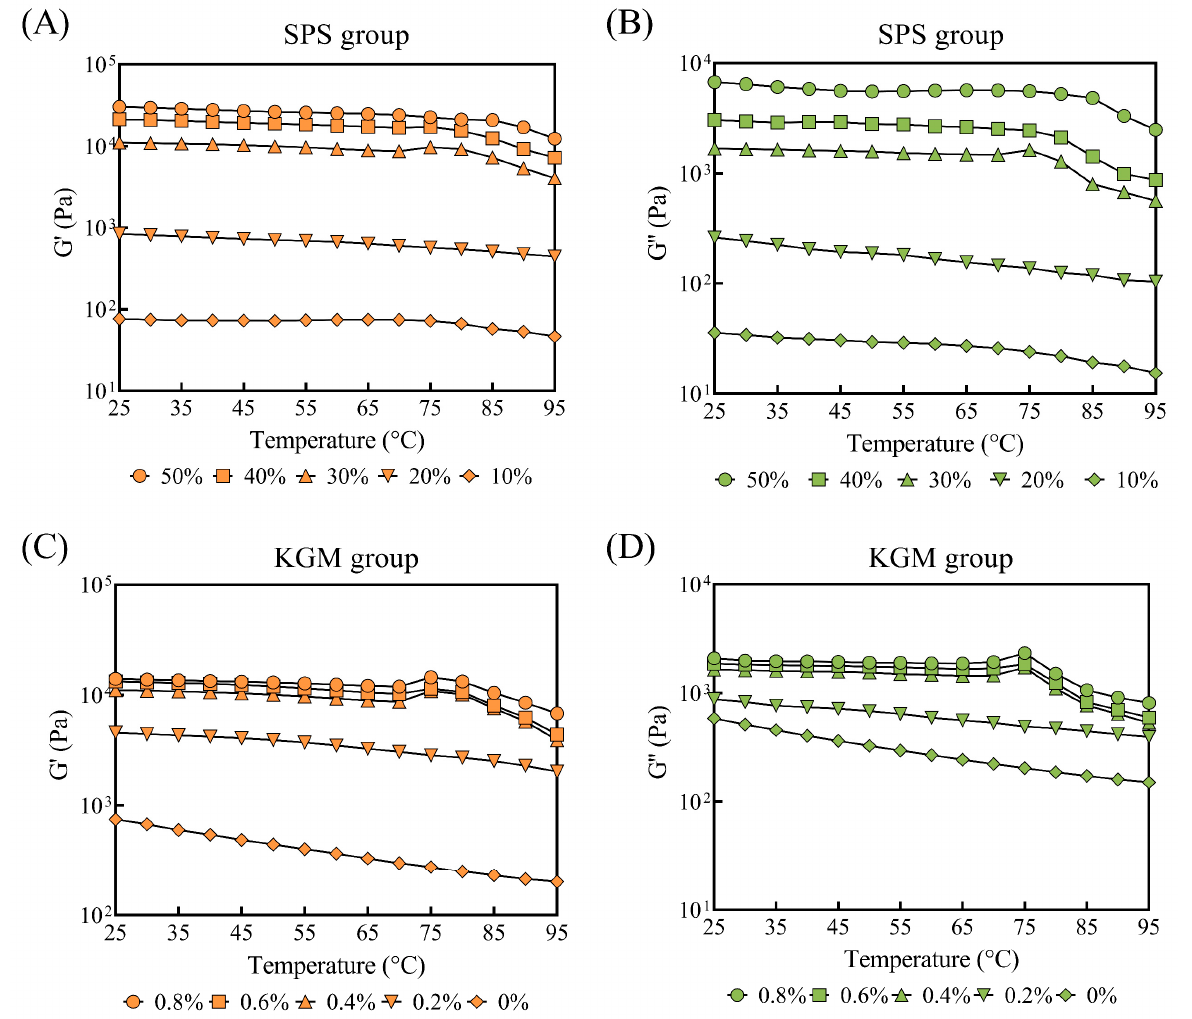
Figure 4. The G’ and G” of the plant-based pork rinds (temperature scanning) containing different SPS ( A , B ) and KGM ( C , D ) concentrations.